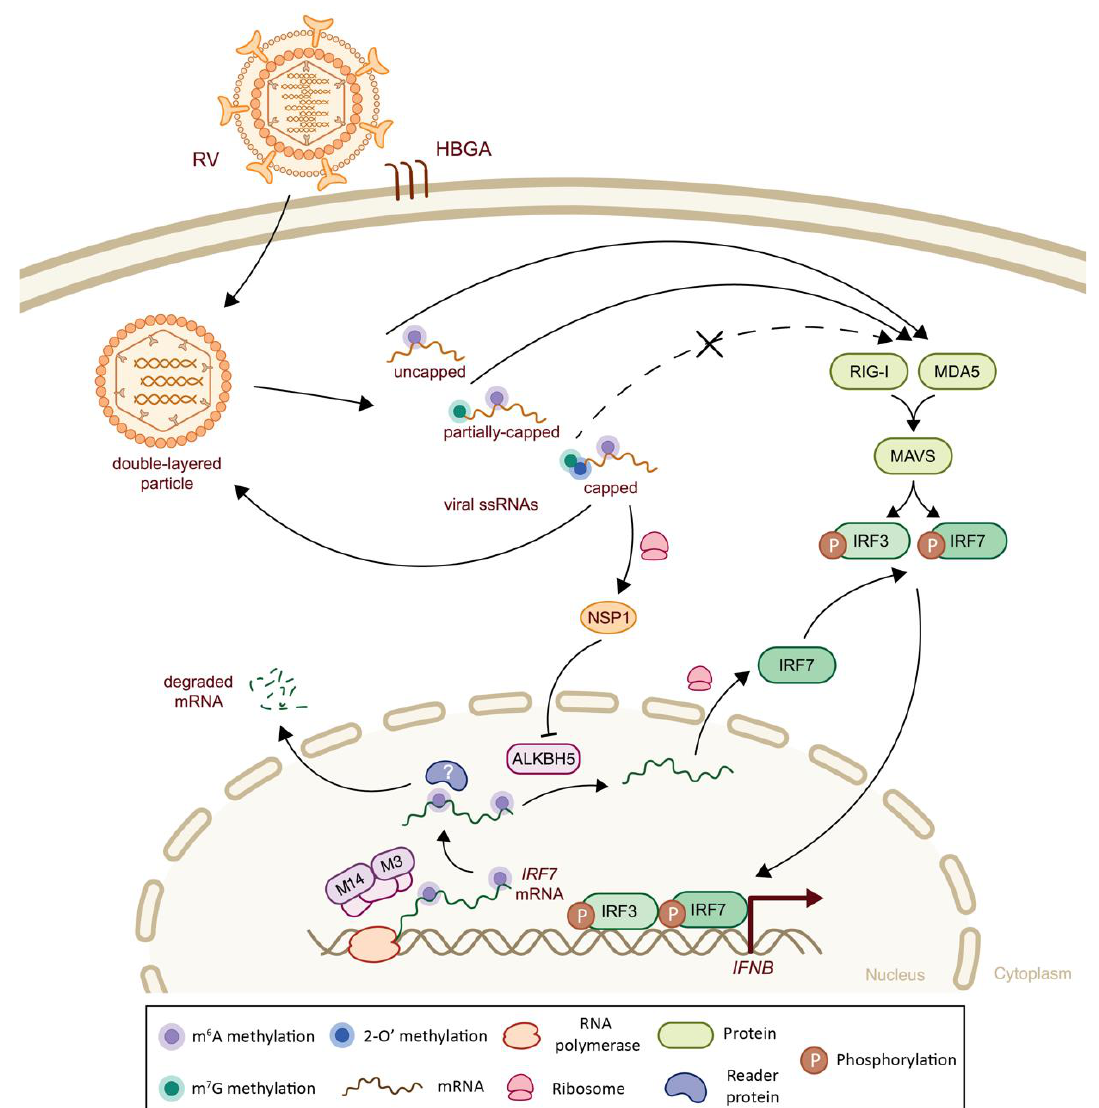
Figure 3. The impact of epitranscriptomic methylations on IFN-I response during RV infection. Upon genomic dsRNA release in the infected cell, rotaviruses (RV) produce non-poly-adenylated ssRNAs and use them as a template for translation and genome replication. RV ssRNAs (or mRNAs) are capped at the 5′ end by the guanylyltransferase and methyltransferase activities of the viral VP3 protein (not shown). However, the insufficient capping efficiency results in a mixed population of uncapped ssRNAs, partially capped ssRNAs harboring m 7 G methylations (filled green circles), or completely capped ssRNAs with both m 7 G and 2′ -O methylations (filled blue and green circles, respectively). The 5′ capping profile dictates ssRNAs sensing, as uncapped and partially capped ssRNAs trigger RIG-I- and MDA5-mediated IFN-I responses, while completely capped ssRNAs escape from sensing. Additionally, viral mRNAs are also m 6 A-methylated (filled purple